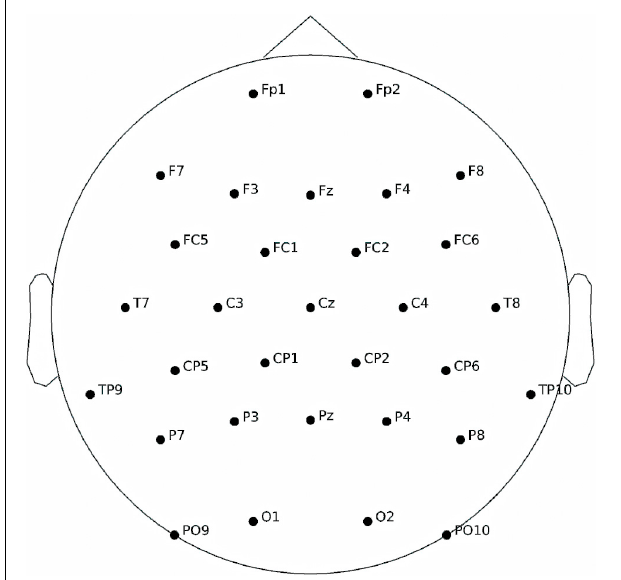
FIGURE 2 | Electroencephalographic channel